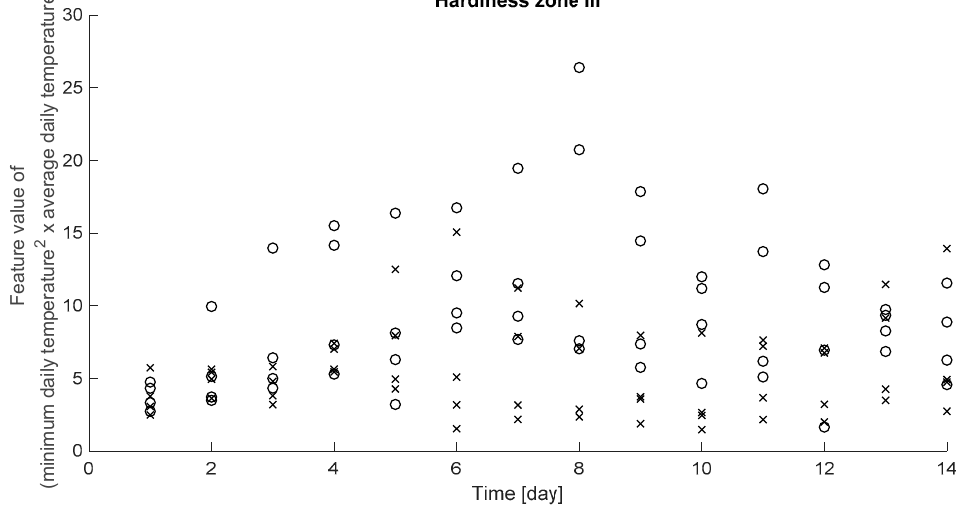
Figure 4. The feature ( T min2 x T av2 [C°]) values of hardiness zone III data. The category 0 data points (four years) are marked by x and category 2 data points (four years) by circles. The observation period is 14 days and t 0 is the beginning of the growing season.